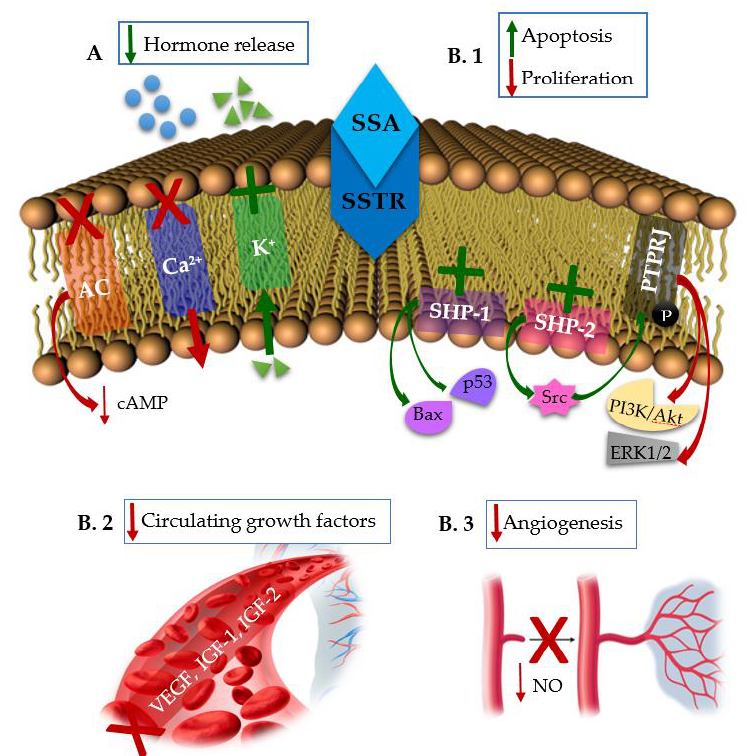
Figure 1. Mechanisms of action of Somatostatin synthetic Analogs (SSAs). ( A ). The antisecretory effects occur through the inhibition of the enzyme adenylyl cyclase (AC), the inhibition of voltage- dependent calcium channels and the stimulation of voltage-dependent potassium channels. ( B ). The antiproliferative effects. ( B.1 ) Direct antiproliferative effects occur through the activation of the Src Homology 2 Domain Phosphatase-1 (SHP-1) and Src Homology 2 Domain Phosphatase-2 (SHP-2). SHP-1 triggers intracellular pro-apoptotic signals by the induction of p53 and Bax, while SHP-2 activates the tyrosine kinase Src that induces the phosphorylation of protein tyrosine phosphatase receptor type J (PTPRJ), which, in turn, dephosphorylates phosphatidylinositol 3-kinase (PI3K/Akt) and extracellular signal-regulated protein kinases 1 and 2 (ERK1/2), impairing cell proliferation. ( B.2 and B.3 ). Indirect antiproliferative effects occur through the inhibition of circulating growth factors like vascular endothelial growth factor (VEGF), insulin-like growth factor 1 (IGF-1), insulin-like growth factor 2 (IGF-2) ( B.2 ) and through the inhibition of tumor angiogenesis by altering the release of nitric oxide (NO) ( B.3 ). (Red “ X ”: Inhibition; Green “ ✚ ”: Stimulation).